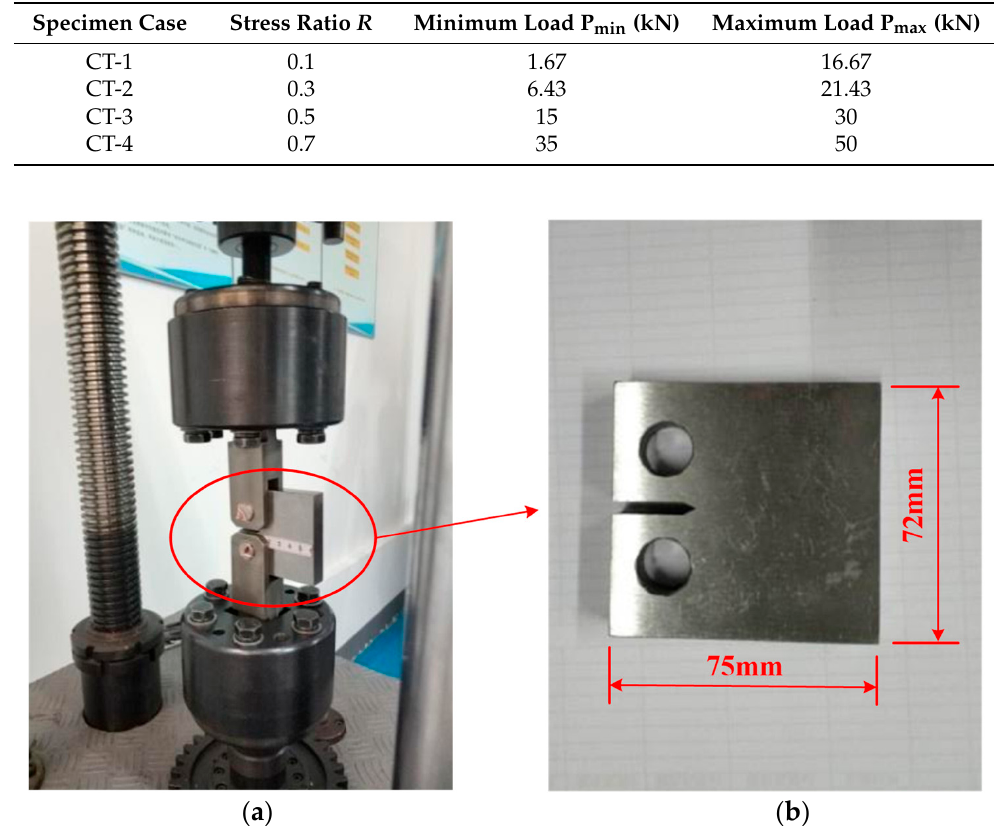
Figure 3. CT specimen installed on the fatigue test equipment. ( a ) QBG-100 fatigue testing machine; ( b ) CT specimen.